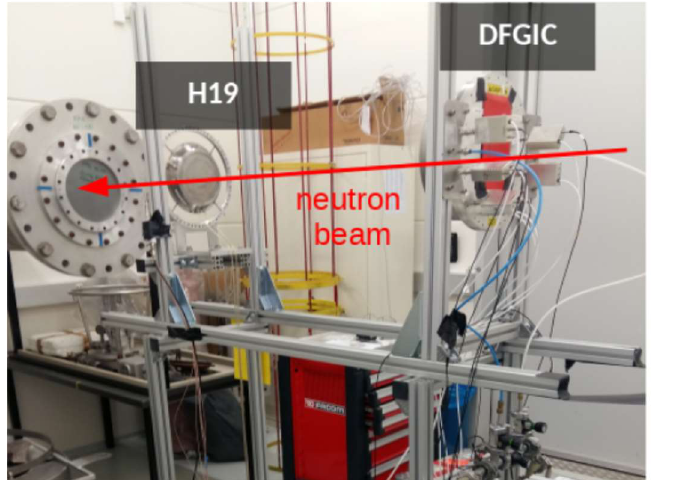
Fig. 2. Detection setup installed at GELINA FP16-60m to measure the 16 O(n,  ) cross section including the Frisch grid ionization chamber from HZDR (DFGIC) and the 235 U loaded fission chamber from PTB (H19)